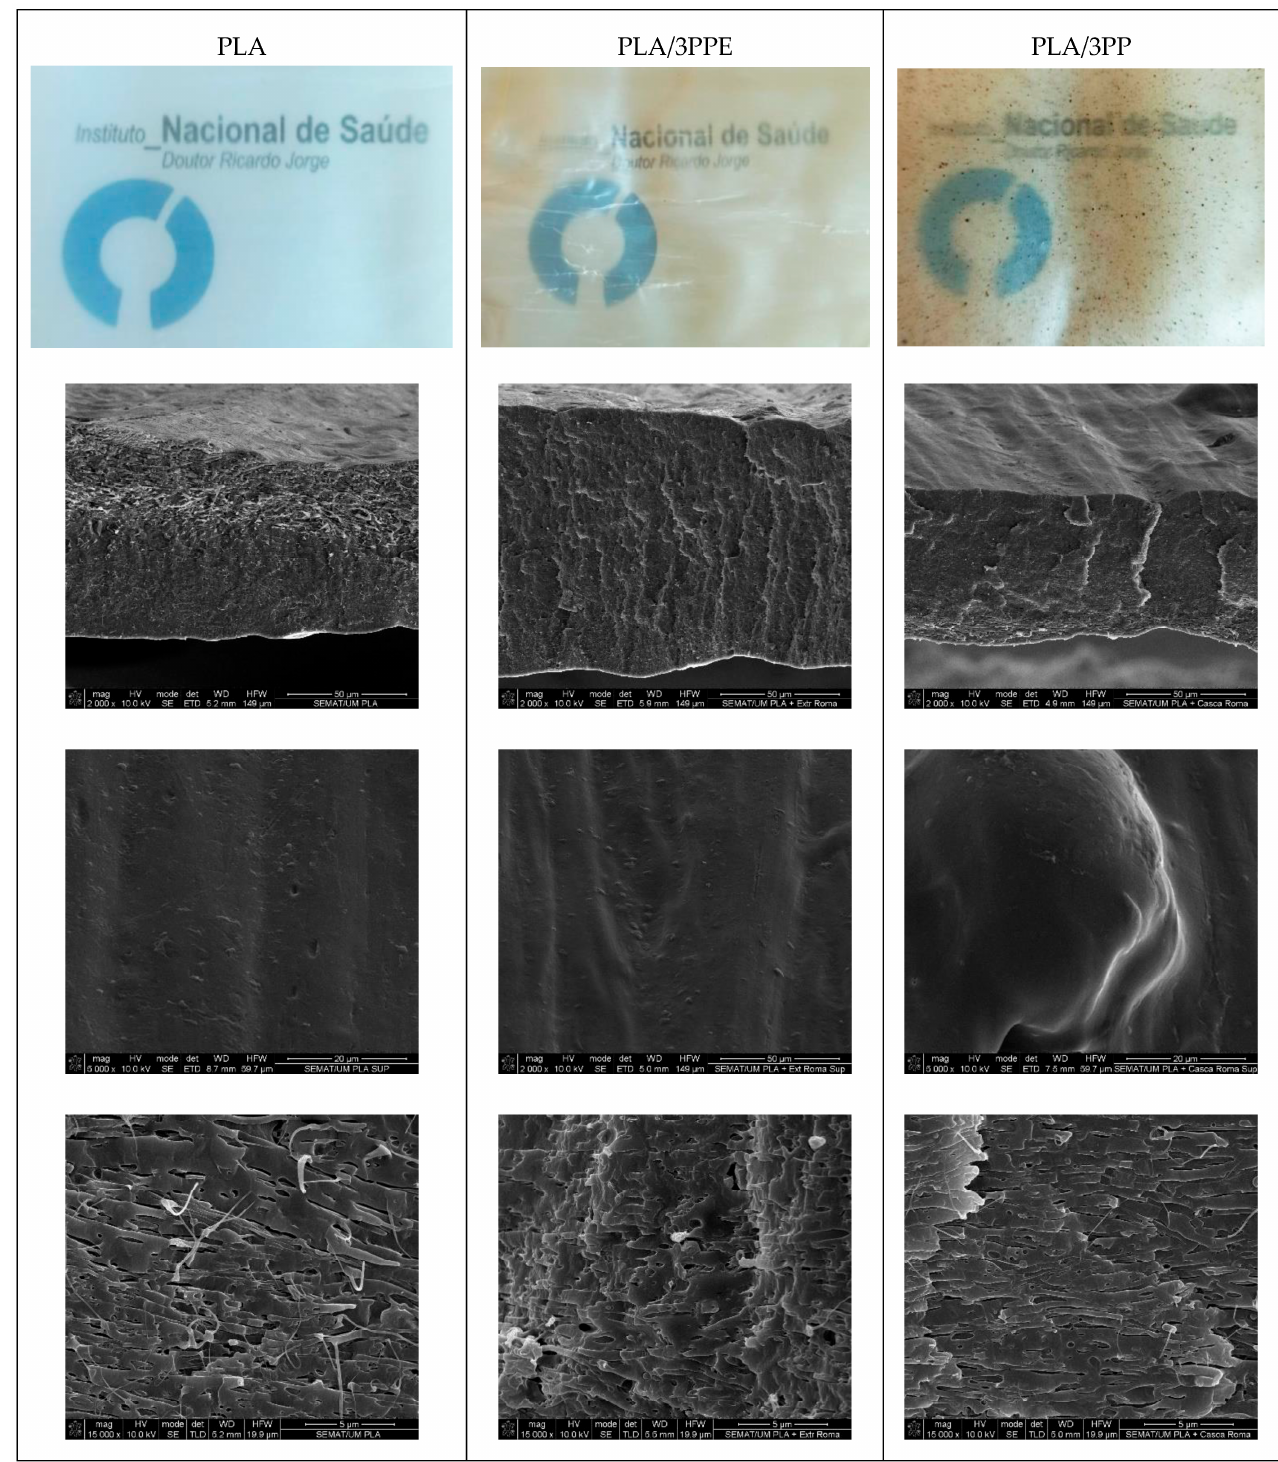
Figure 2. Photographs of the control (PLA) and the active (PLA/3PPE and PLA/3PP) films and the respective SEM